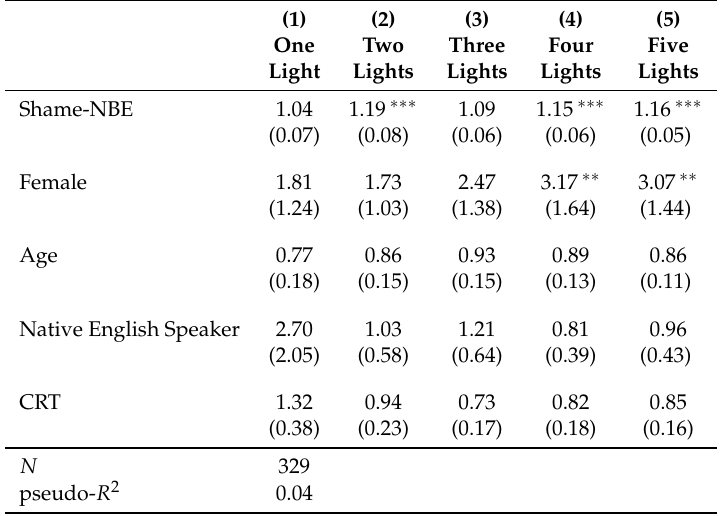
Table A4. Predicting Number of Lights by Shame: Multinomial Logit